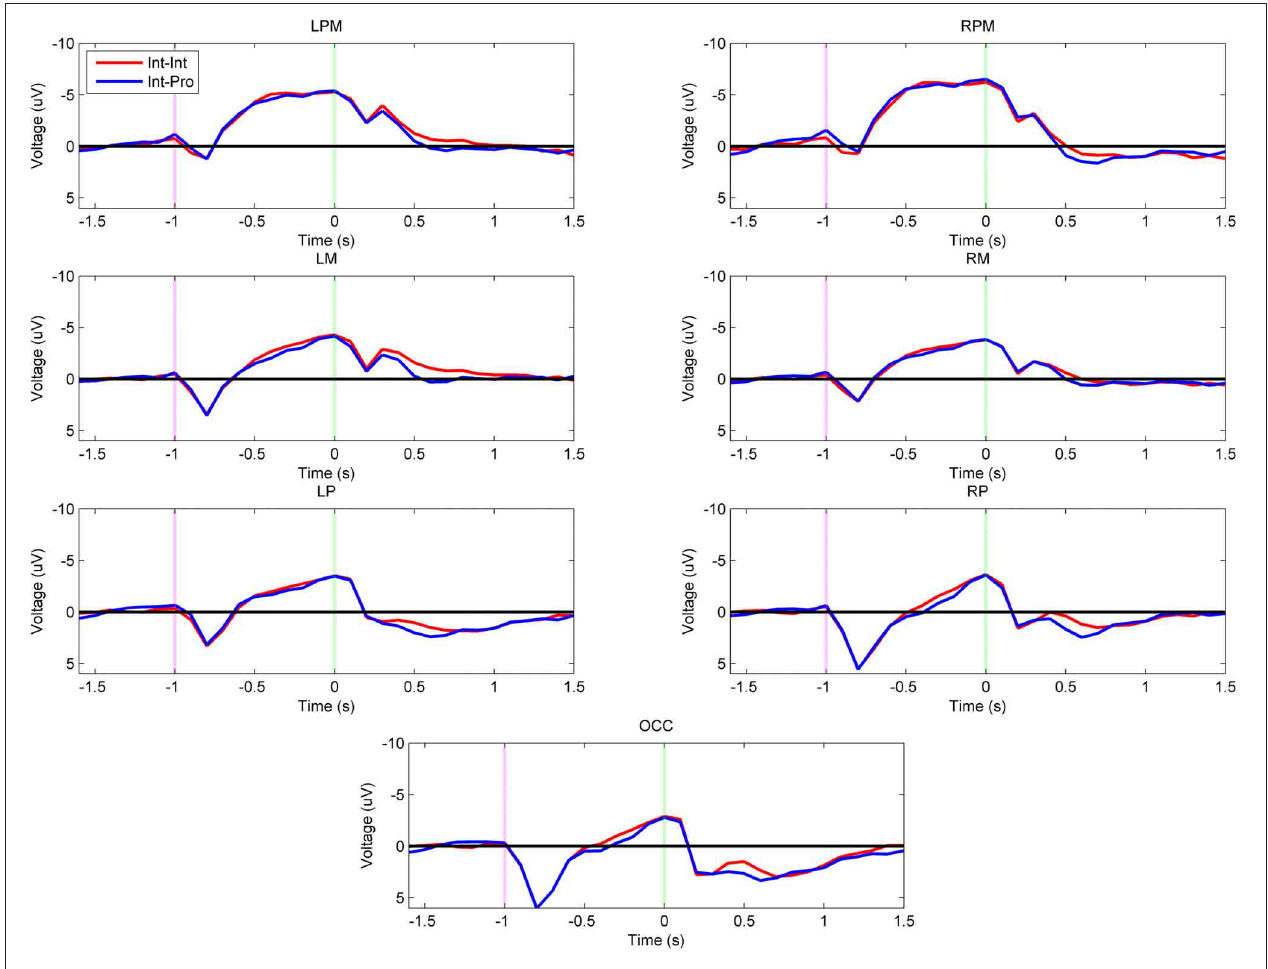
FIGURE 2 | Grand-averaged region-level voltage plots for the Int–Int (red) and Int–Pro (blue) groups. The planning cue is marked with a pink dotted line at –1.0s and the execution cue is marked